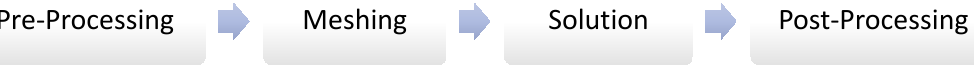
Figure 11. Steps for applying the CFD in software.